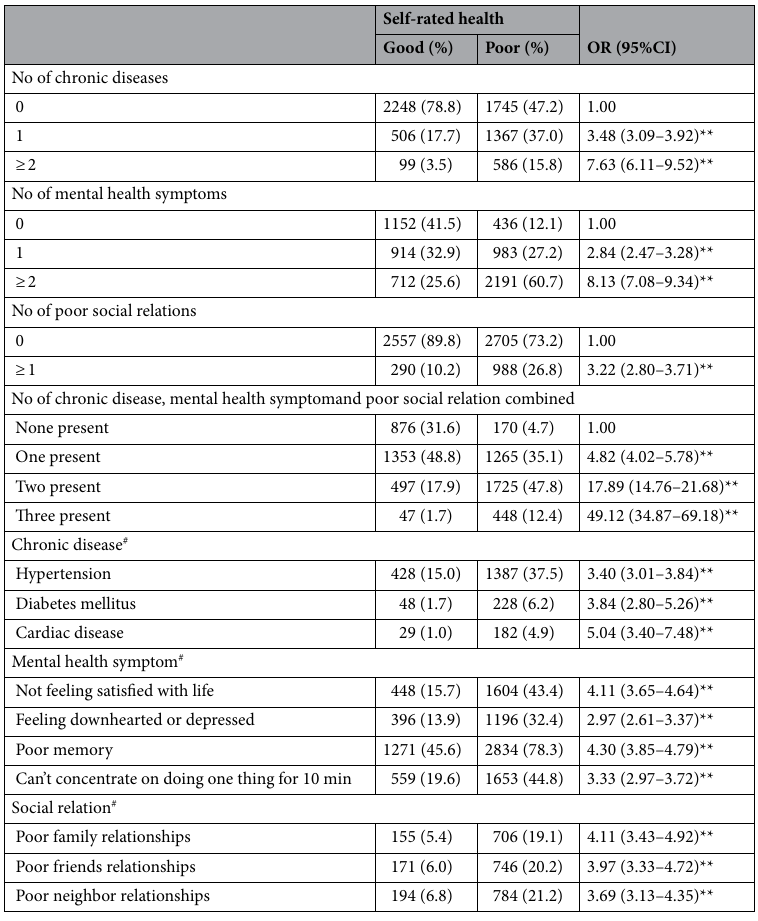
Table 3. Bivariate analysis for relationship of chronic disease, mental health symptom and poor social relation with self-rated health. # Both counts and percentages are based upon weighted inputted values. **The reference category is subjects without the specified condition, P <